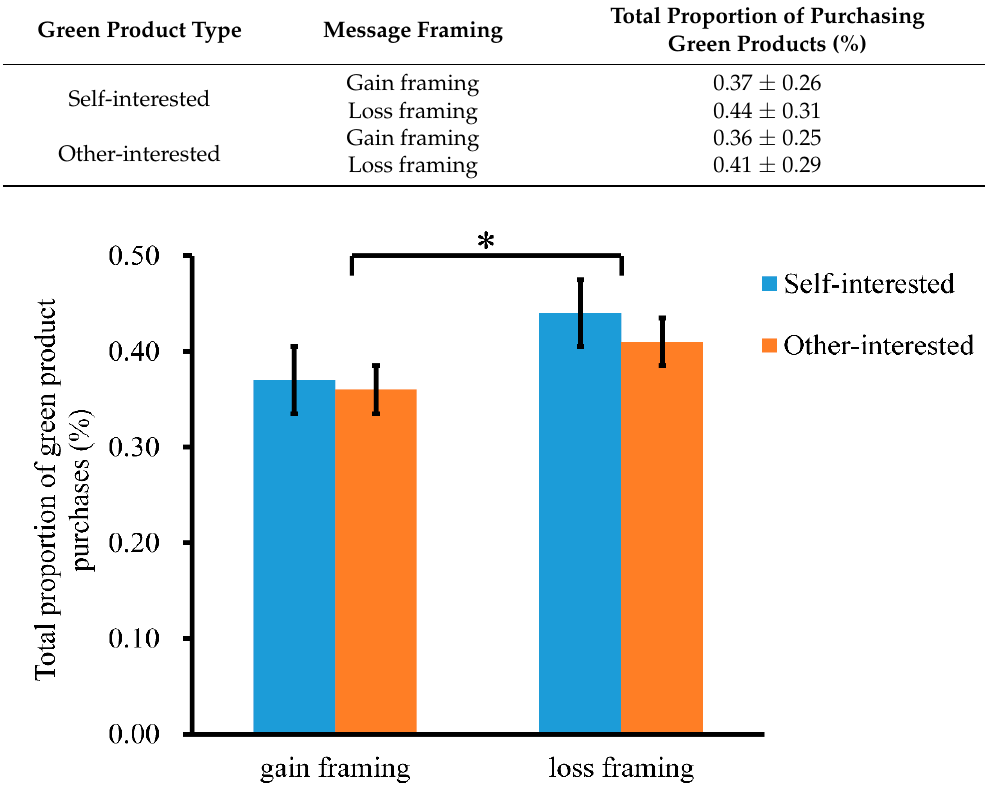
Figure 3. Bar graph of the total proportion of green product purchases in each condition. * p < 0.05.